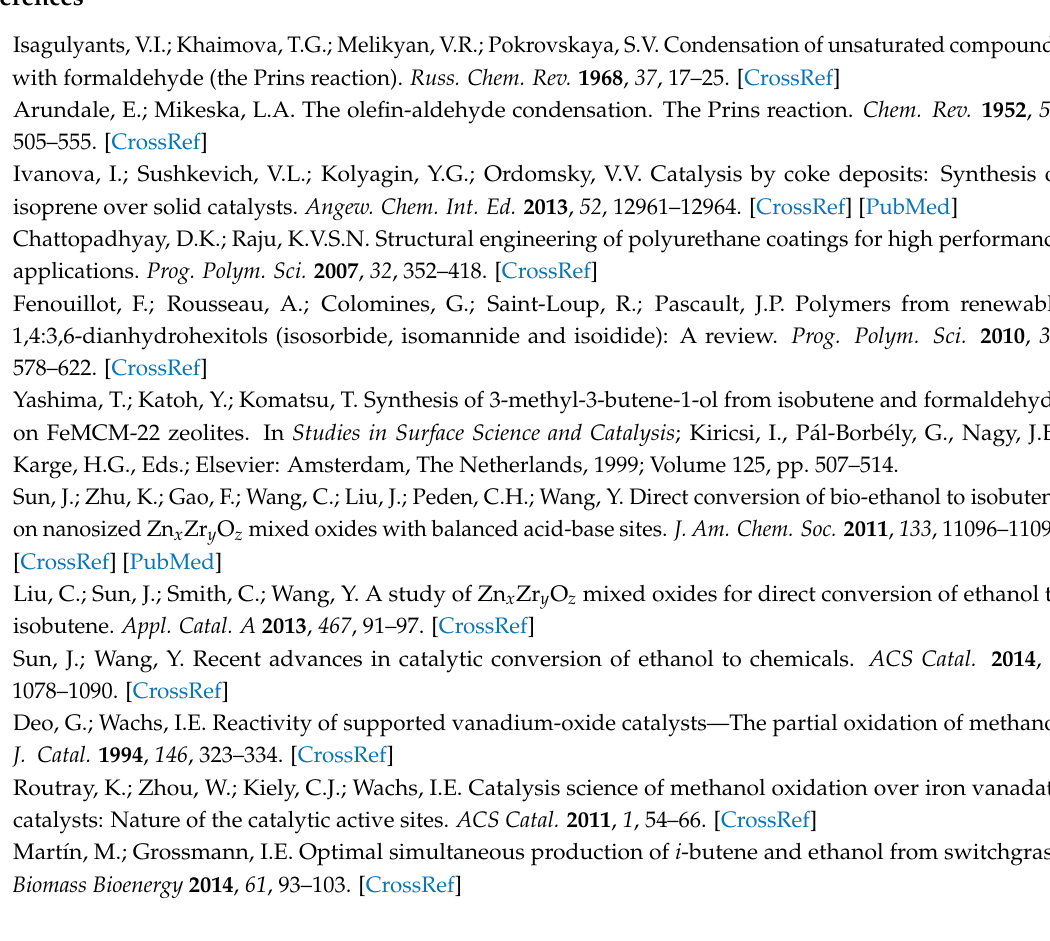
Figure S1: XRD patterns of CeO 2 with different morphologies, Figure S2: Figure S3: Raman spectra of ( a ) CeO 2 -rod; ( b ) CeO 2 -octahedron; and ( c ) CeO 2 -cube, Table S1: Prins condensation-hydrolysis of isobutene with HCHO in water over CeO 2 with different